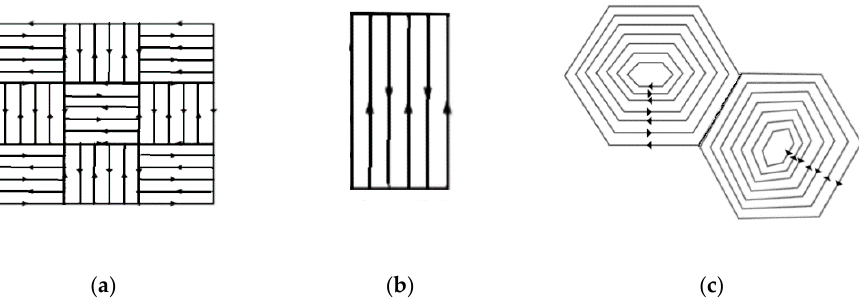
Figure 1. Scan strategies with ( a ) chessboard scanning strategy, ( b ) stripes scanning strategy, and ( c ) hexagonal scanning strategy.